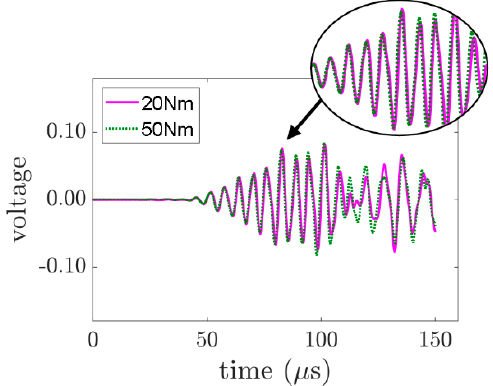
Figure 6. Measured responses of two levels of applied torque.